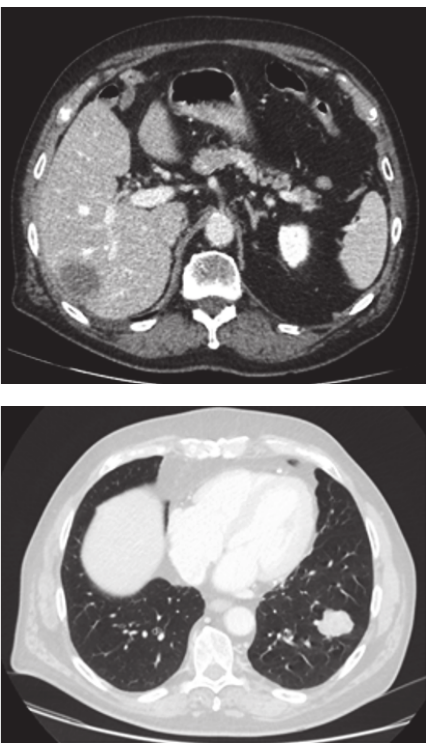
Figure 1: Computed tomography scan of the patient of case 1 at the diagnosis of metachronous hepatic and pulmonary metastases.